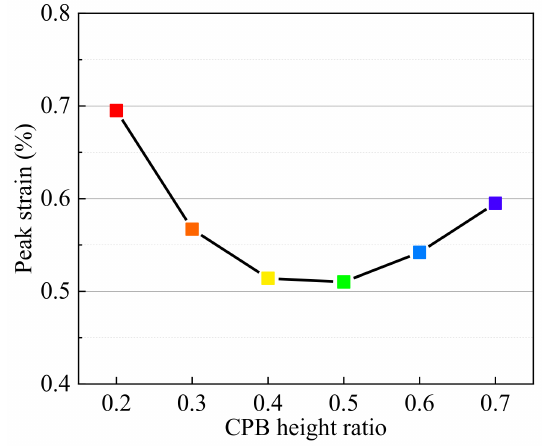
Figure 6. Peak strain and CPB height ratio of RCF